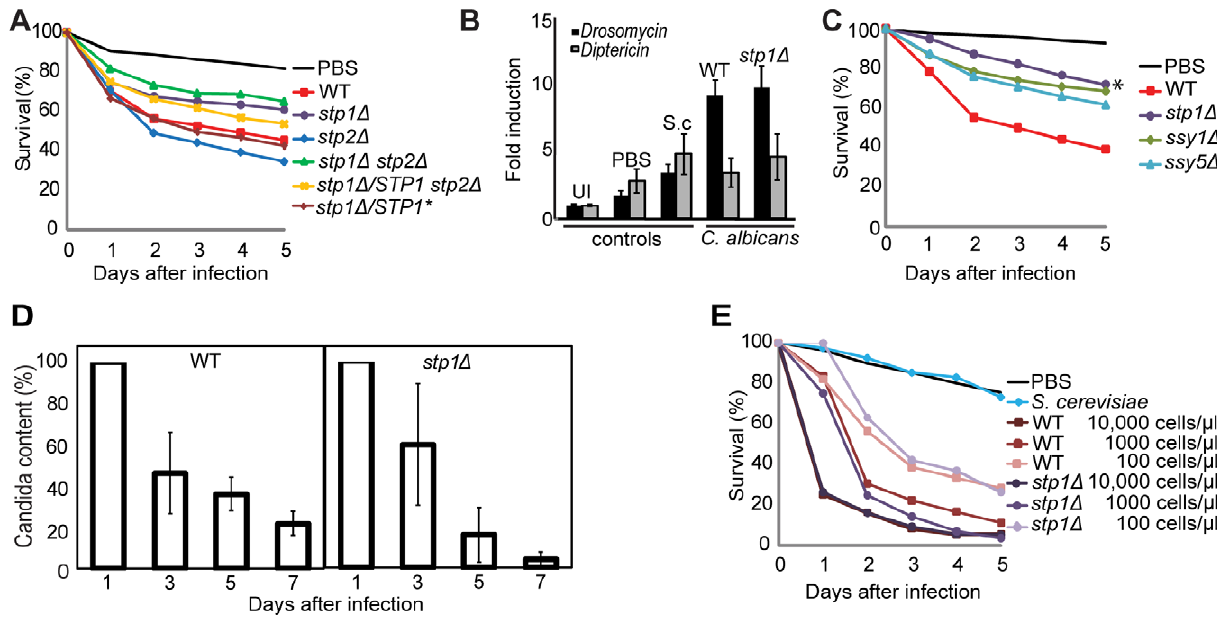
Figure 4. A functioning SPS-sensing pathway is required for virulence. A. OrR flies (n=500) were injected with PBS or wild-type (WT; PMRCA18), stp1 D (PMRCA59), stp2 D (PMRCA57), stp1 D stp2 D (PMRCA94), stp1 D /STP1stp2 D (PMRCA95), and stp1 D /STP1* (PMRCA60) C. albicans strains (10,000 cells/ m l). B. The levels of Drosomycin and Diptericin expression (normalized to RpL32 ) were analyzed by quantitative RT-PCR in un-injected (UI) flies and in flies 20 hours post-injection with PBS, S. cerevisiae (S.c.;KRY001), wild-type (WT; PMRCA18) or stp1 D (PMRCA59) C. albicans . C. OrR flies (n=500) were injected with PBS or wild-type (WT; PMRCA18), stp1 D (PMRCA59), ssy1 D (YJA64), and ssy5 D (YJA53) C. albicans strains (10,000 cells/ m l). Cohorts of 500 flies were injected. D. Pathogen loads were monitored by quantitative PCR using DNA isolated from OrR flies infected with wild-type (WT; PMRCA18) or stp1 D (PMRCA59) C. albicans . Levels of CaACT1 DNA were normalized to levels of DmRpL32 DNA and relative to values determined at Day 1 post-infection (set to 100) are plotted. Error bars represent SEM. E. Tl 632 /Tl (1-RXA) flies (n $ 50) were injected with PBS, S. cerevisiae (KRY001) at 10,000 cells/ m l, or C. albicans strains wild-type (WT; PMRCA18) or stp1 D (PMRCA59) at 10,000, 1000, or 100 cells/ m l. Statistically significant differences from the survival of the flies injected with WT C. albicans are marked by an